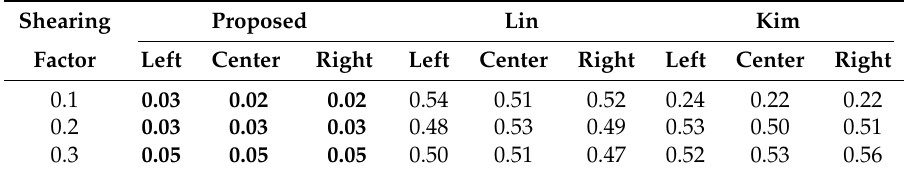
Table 12. Average BER for shearing attack.